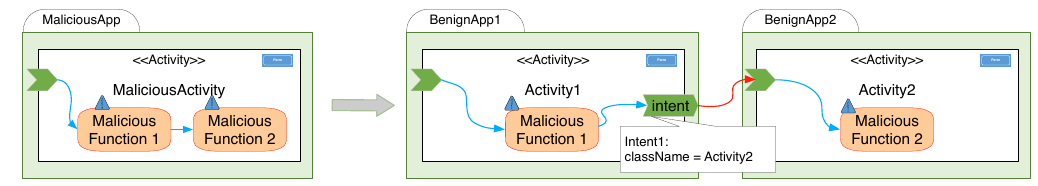
Figure 1. Motivation example of evasion